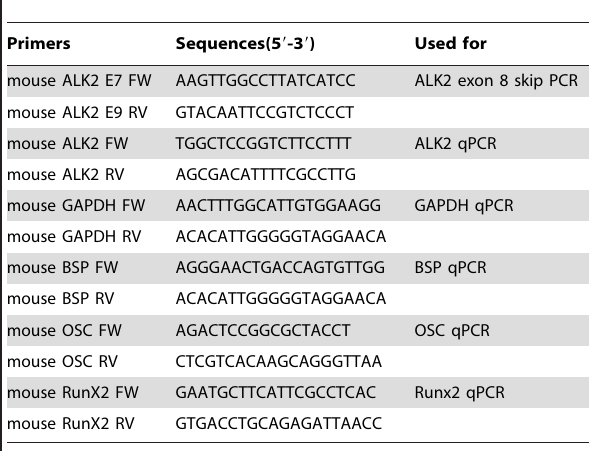
Table 2. Primers used in this